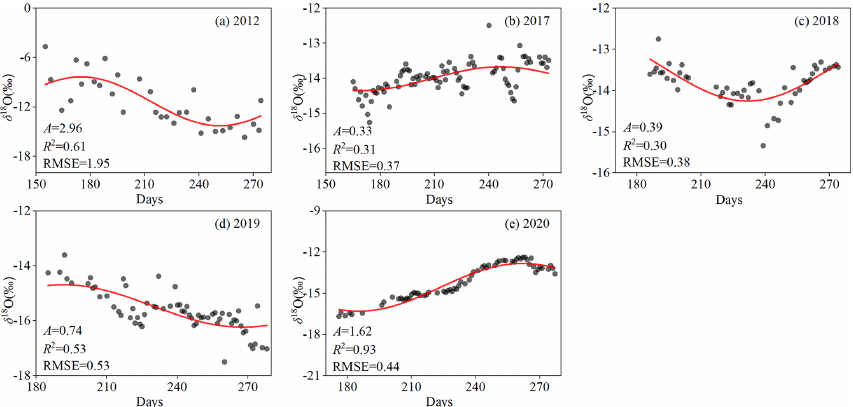
Figure 9. Fitted sine-wave regression models to δ 18 O in supra-permafrost water in Xiaoliuyu catchment during 2012 and 2017–2020. A is the amplitude, and RMSE is root mean square error for the modelled isotopic